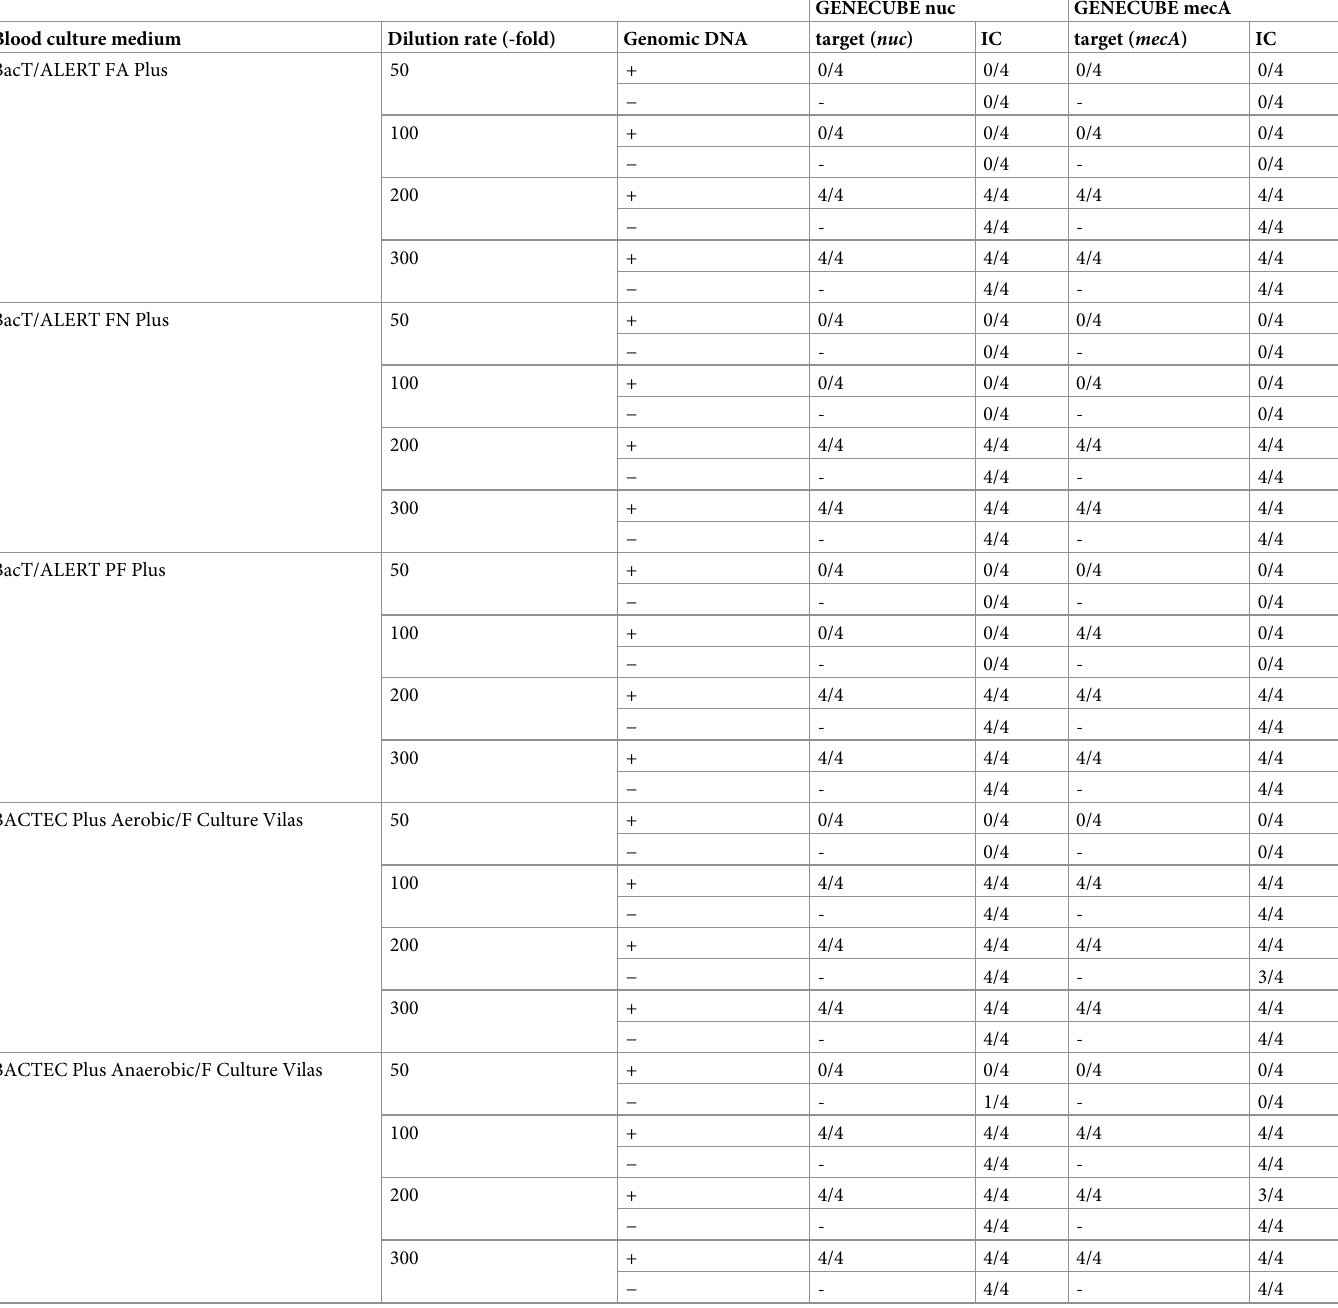
Table 4. Numbers of positive replicates in the GENECUBE nuc and GENECUBE mecA assays in diluted blood culture